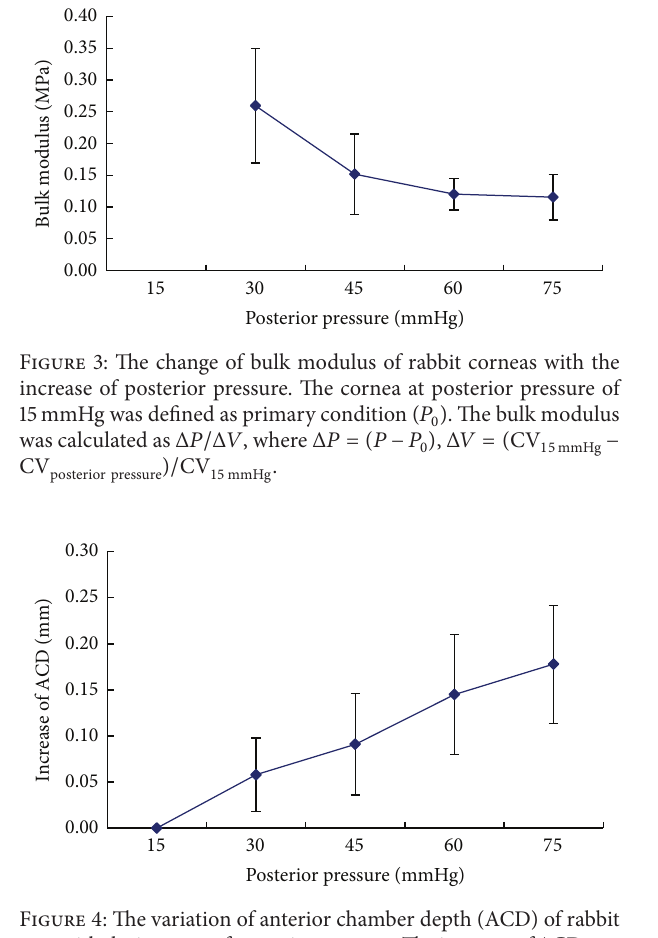
Figure 4: The variation of anterior chamber depth (ACD) of rabbit eyeswiththeincreaseofposteriorpressure.TheincreaseofACDwas − ACD ) . With the increase calculated as ( ACD 15 mmHg posterior pressure of posterior pressures, ACD gradually elevated and the change of ACD was almost linear ( 𝑅 2 = 0.9913